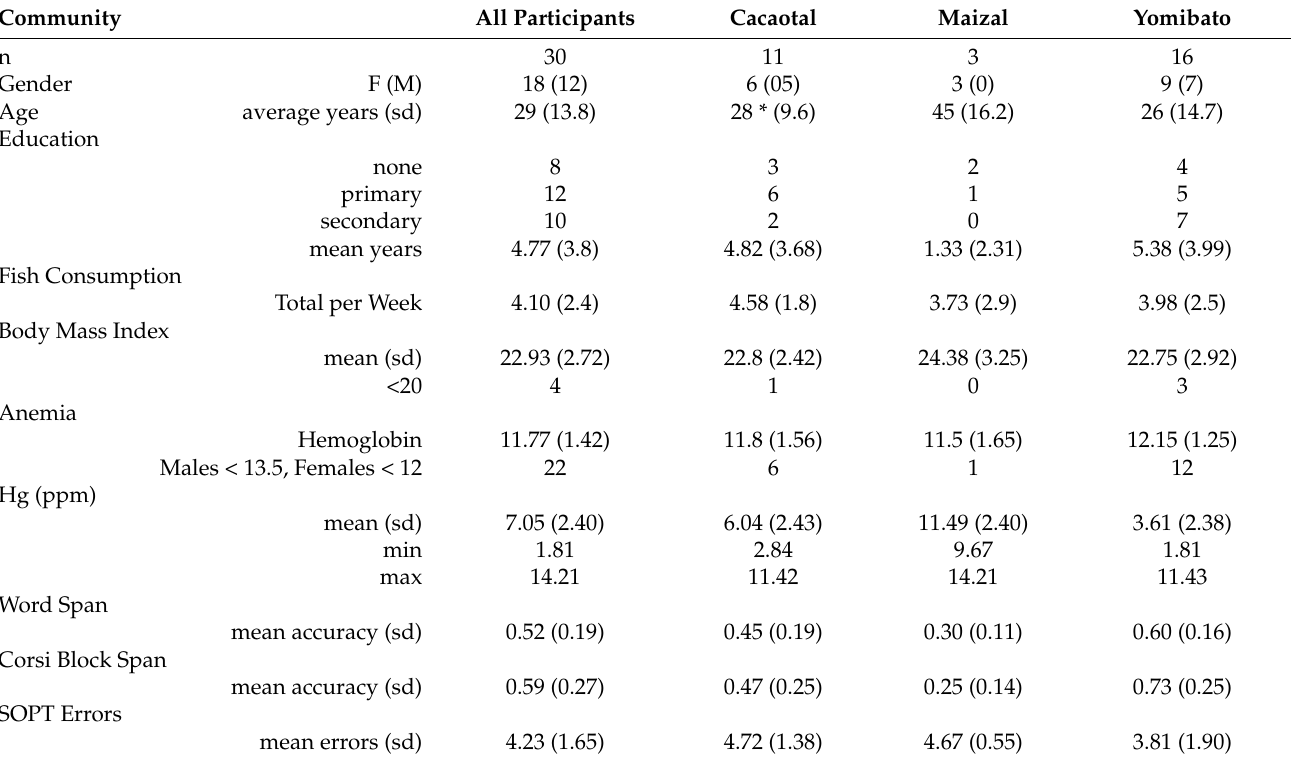
Table 1. Summary Statistics for Demographics, Health and Diet Indicators, and Cognitive